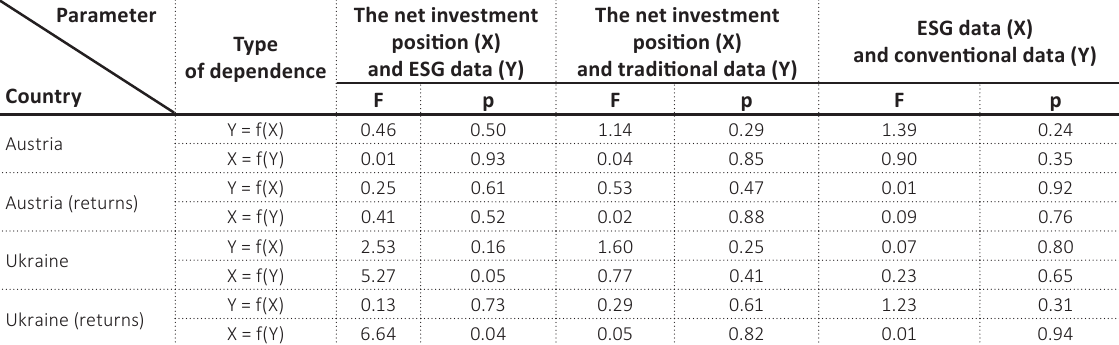
Table 4. Granger causality tests for the case of Ukraine and Austria Parameter